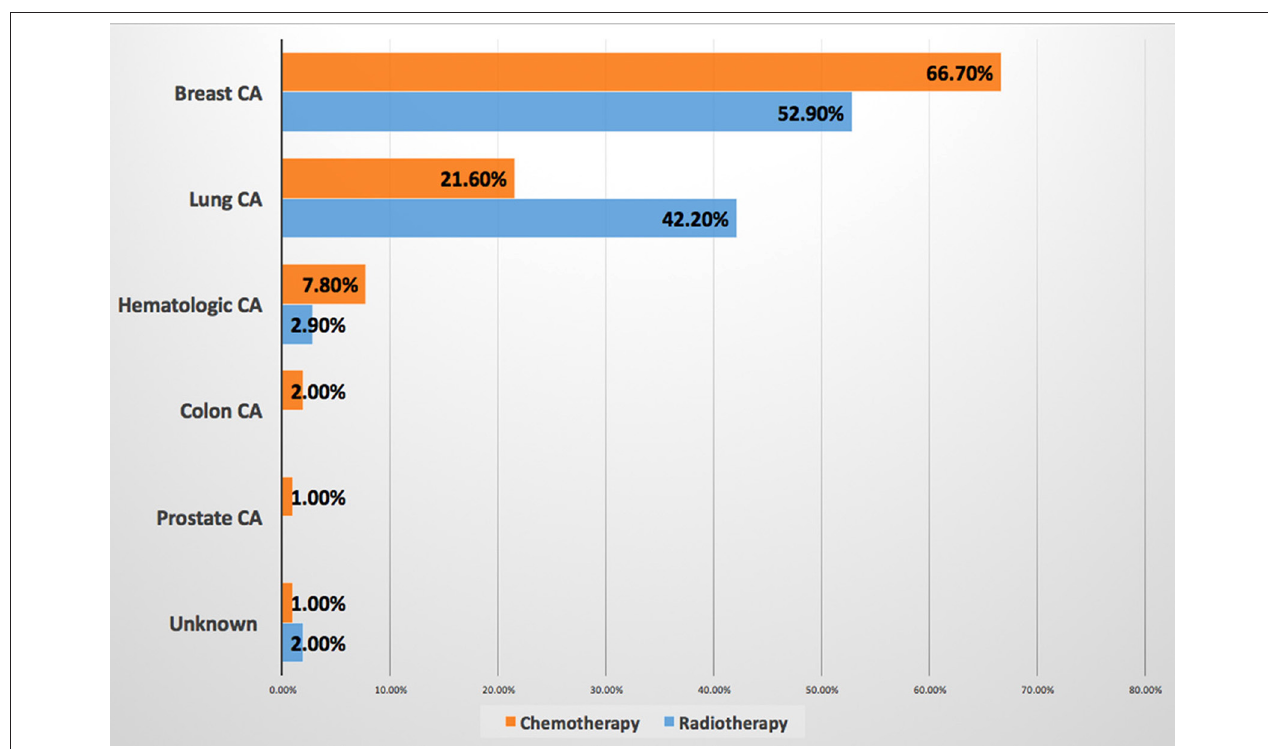
FIGURE 3 | Most cancer types associated with cancer therapy-induced cardiovascular disease. Breast cancer is the most common malignancy associated with CVD induced by both chemotherapy and radiation therapy. CA, cancer; CVD, cardiovascular disease.